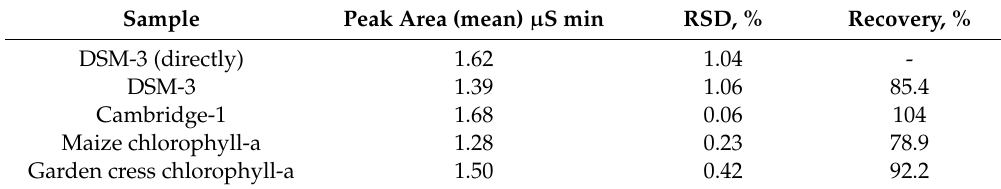
Table 1. Magnesium recovery in analytical procedure (acid-digestion, evaporation, reconstitution